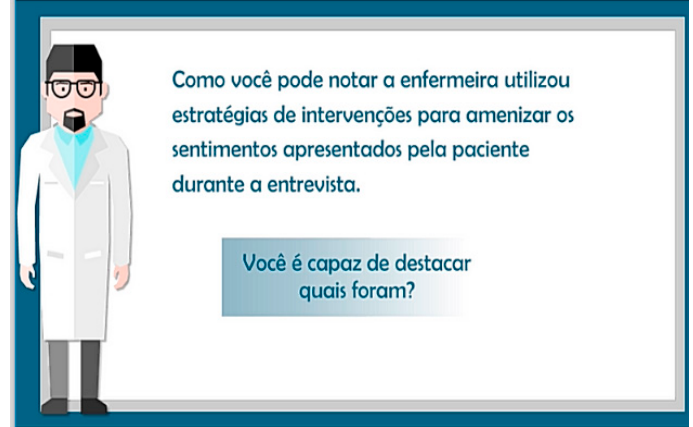
Figure 4. Discussing interventions (table content explained in English in the text).